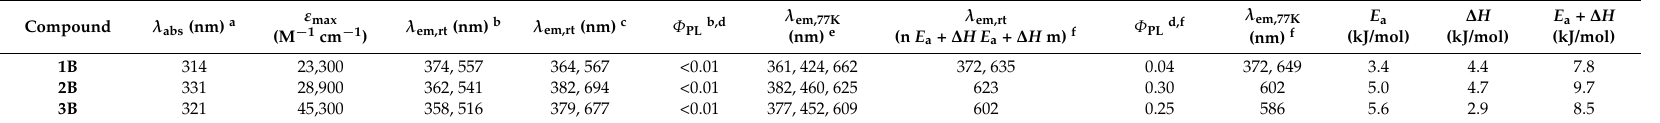
Table 1. Optical properties of 1 – 3B .